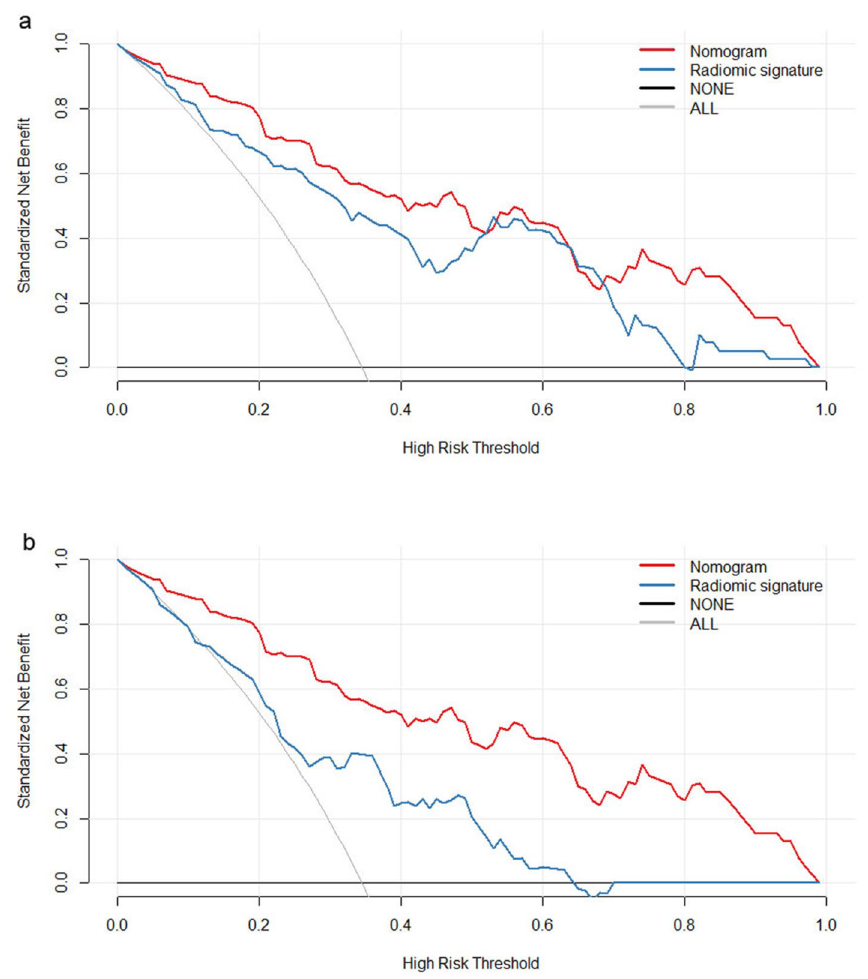
Figure 5. Decision curve analysis (DCA) for the radiomics nomogram along with ( a ) combined gross and peritumoral volume (GPTV) radiomic signature and ( b ) lymph node (LN) radiomic signature. Gray line represents the assumption that all patients have LN metastasis. Black line represents the assumption that all patients have negative LN metastasis. Red curve represents the radiomics nomogram (in both ( a , b ). Blue curve represents the GPTV radiomic signature (in a ) and LN radiomic signature (in b ). The x-axis shows the threshold probability. The y-axis shows the net benefit. It is clear from the graph that the radiomics signature and nomogram are superior to either treat-all or none strategy within certain ranges of